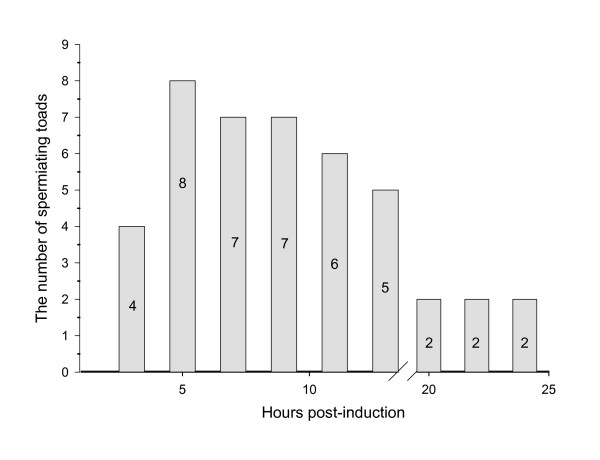
The number of toads (n = 10) spermiating over 25 hrs post-induction to a single intraperitoneal dose of 300IU of hCG.